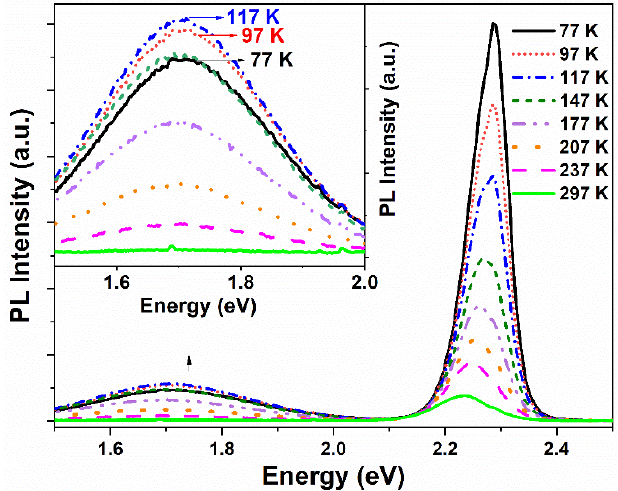
Figure 2. PL spectra of CdS/ZnS core/shell QDs at different temperatures from 77 to 297 K. Inset shows the magnified PL spectra of surface state of CdS/ZnS core/shell QDs.